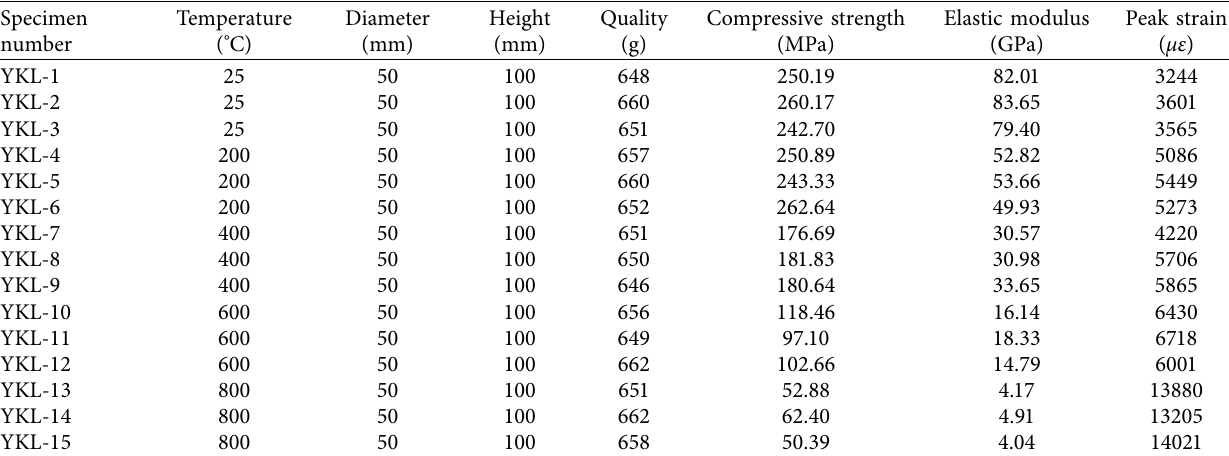
Table 1: Uniaxial compression test data (natural cooling).